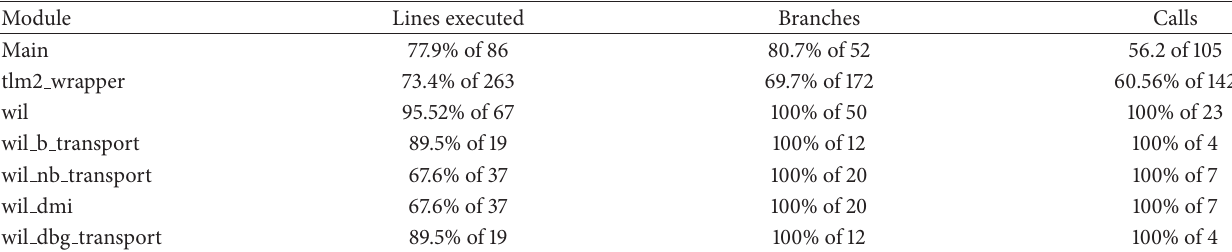
Table 2: Interception libary distribution example coverage.